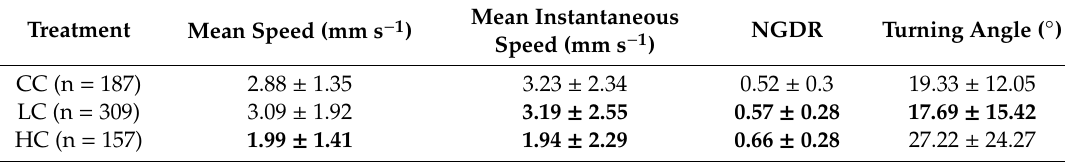
Table 1. E ff ects of microplastics in the swimming activity of T. turbinata . CC = Control; LC =